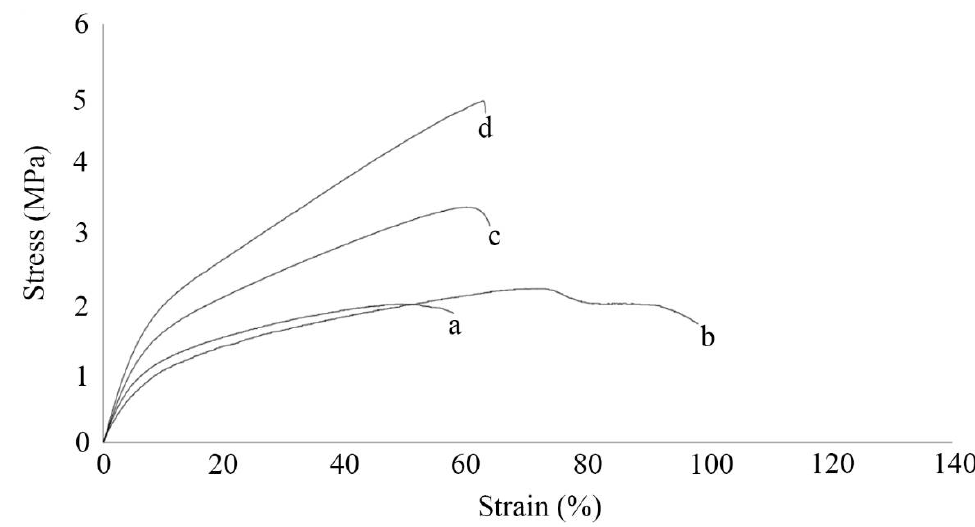
Figure 9. Tensile strength of the fibrous scaffolds, ( a ): PCL, ( b ): 3MNP, ( c ): 5MNP, and ( d ): 10MNP. Table 2. Mechanical properties of fibrous scaffolds.